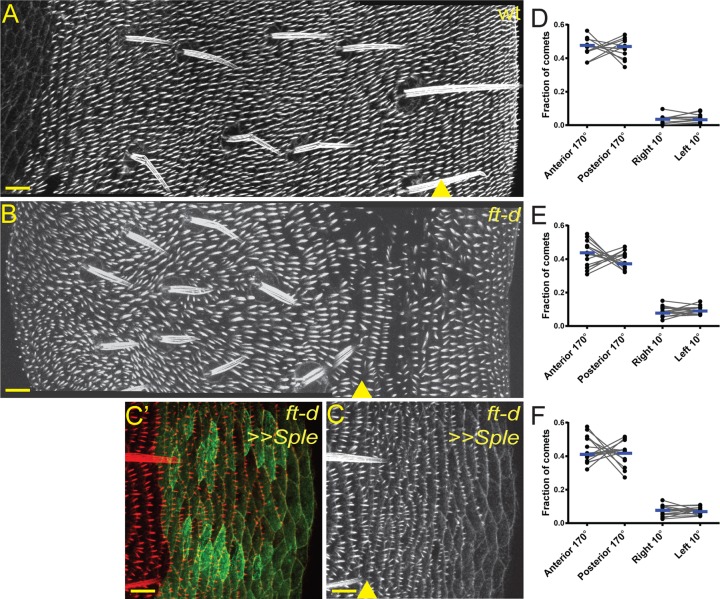
Direction of hair growth and microtubule polarity in ft, d mutant abdomens. (A-C′) Abdominal segments from wild-type (A, genotype 17), ft-d null (B, genotype 18), and ft-d null, overexpressing Sple (C,C′, genotype 12) flies stained with phalloidin to visualize actin-rich prehairs. Yellow triangle indicates approximate location of anterior-posterior compartment boundary. HhGal4-driven UAS-Eb1::GFP expression marks the posterior compartment in C′. Scale bar=10 µm. >> denotes overexpression. (D-F) The proportion (fraction) of Eb1::GFP comets observed moving in a given direction in ft, d mutant A-abds (D, P=0.9697; 3471 comets from n=12 flies; genotype 13); ft, d mutant P-abds (E, P=0.3591; 2091 comets from n=15 flies; genotype 11); and ft, d mutant, Sple overexpressing P-abds (F, P=0.8160; 2077 comets from n=15 flies; genotype 12). Grey lines link values from the same fly; blue bars mark the median; P-values are from a Wilcoxon matched-pairs signed rank test.